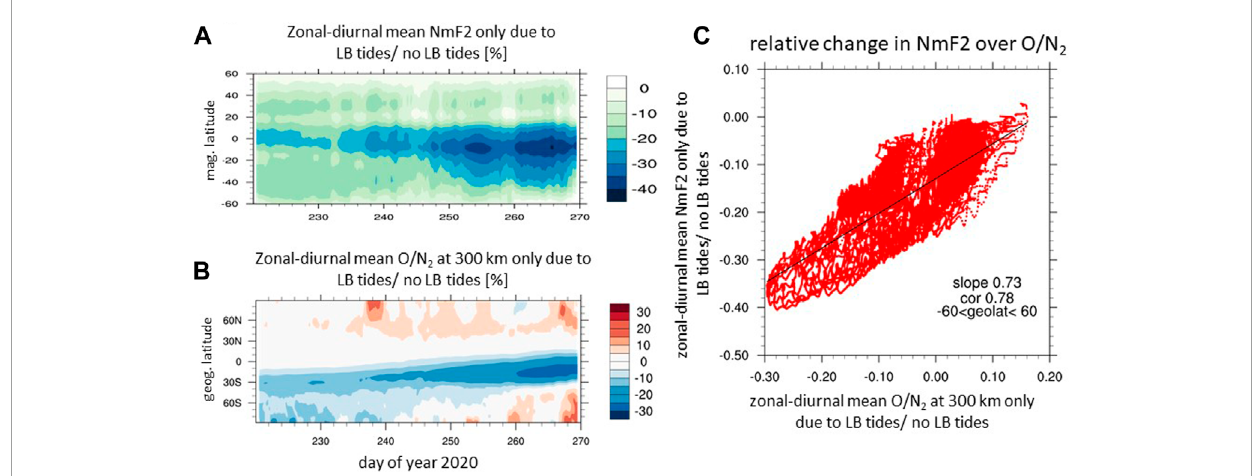
FIGURE 8 Time evolution of the relative change in the zonal and diurnal mean (A) . NmF2 over quasi dipole latitude and (B) O / N 2 ratio at 300 km over geographic latitude due to lower atmospheric tidal forcing with respect to no tidal forcing; (C) correlation between relative NmF2 change and O / N 2 equatorward of | λ m | ≤ 60 o and | λ g | ≤ 60 o , respectively for the time